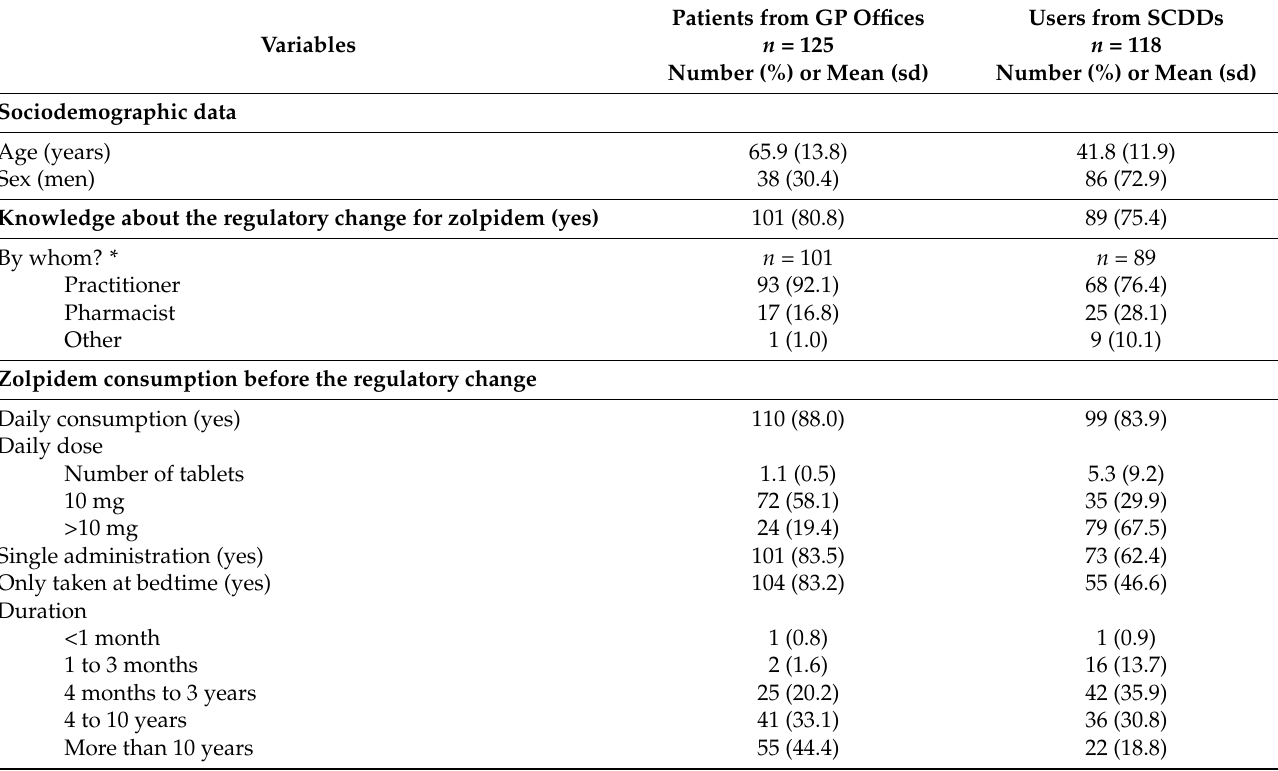
Table 1. Characteristics of the participants included in the